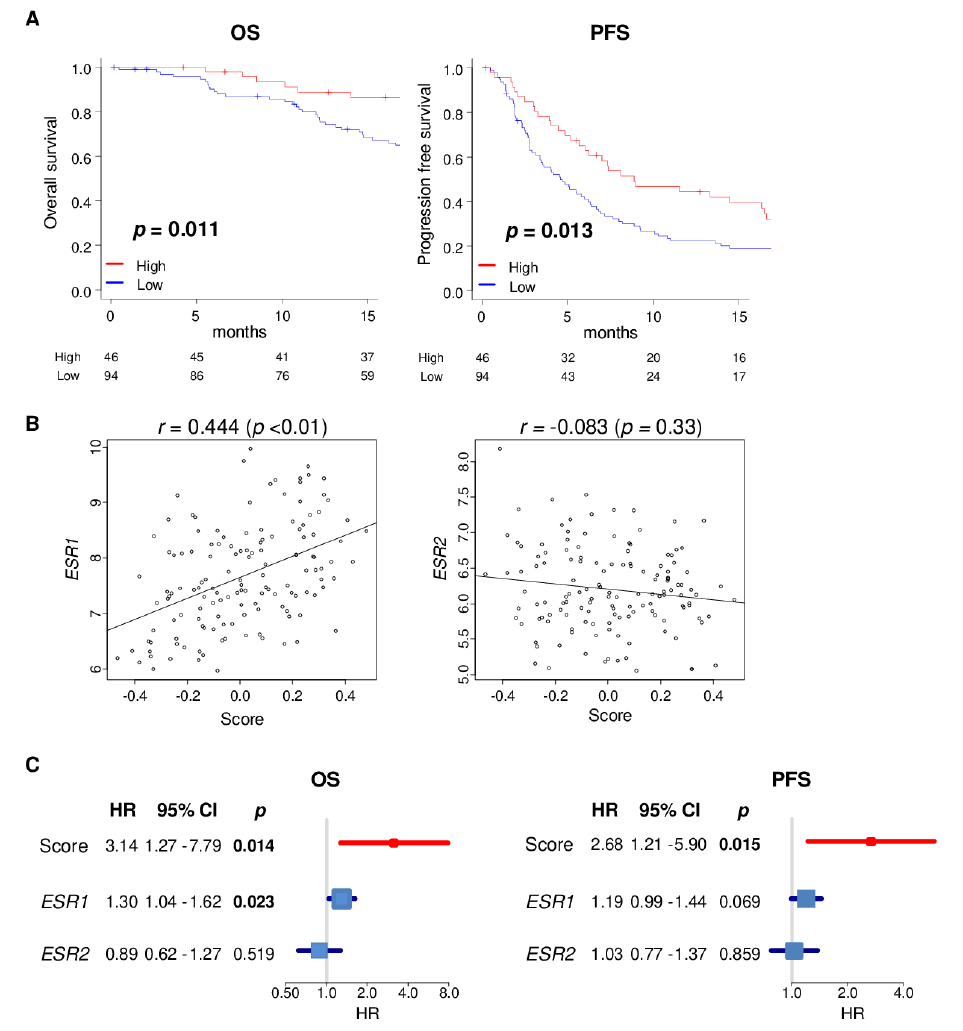
Figure 6. Association of the estrogen response early scores with patient survival in metastatic breast cancer in the GSE124647 cohort ( n = 140). ( A ) Kaplan-Meier with log-rank p -value between low (blue) and high (red) score with overall survival (OS) and progression-free survival (PFS). The top one-third was defined as the high score group within the cohort. ( B ) Correlation plots of the score with the expression of the ESR1 or ESR2 genes in the GSE124647 cohort. P -value was calculated by Spearman’s rank correlation coefficient. ( C ) Forrest plots of the estrogen response early score, ESR1 and ESR2 expression with OS and PFS. P -value was calculated by cox regulation model. HR; hazard ratio, CI; confidence interval.